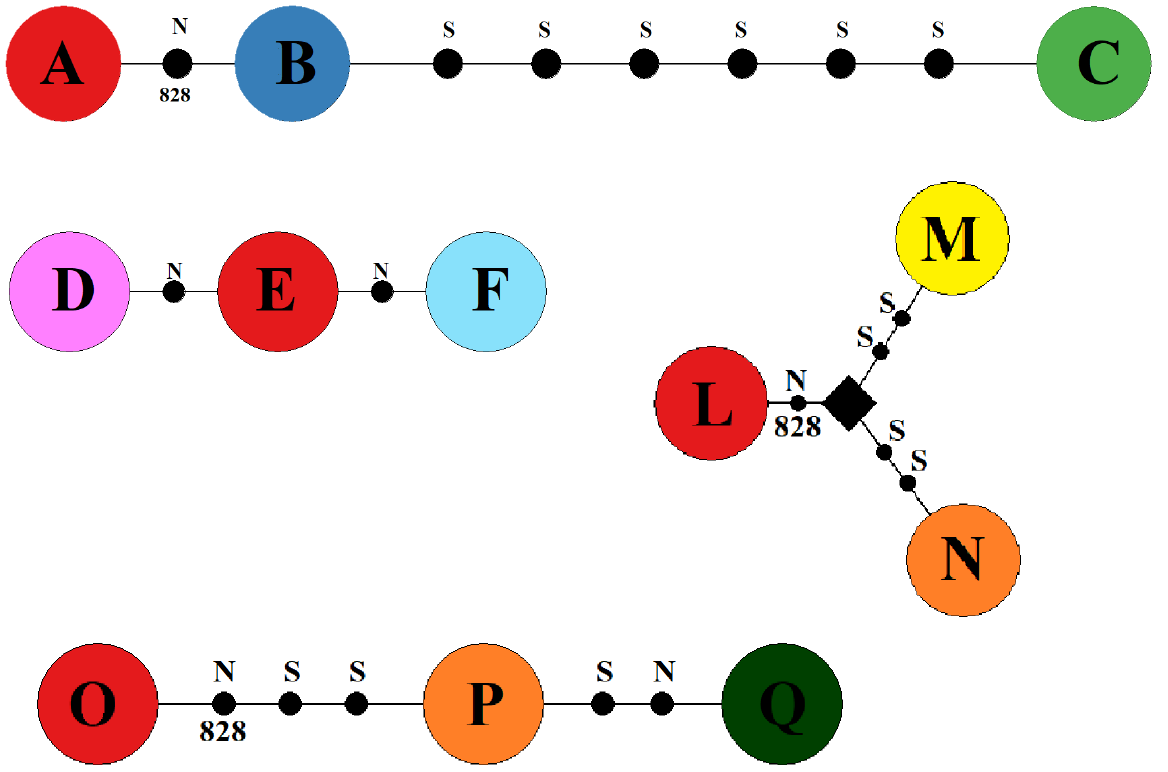
Figure 2. Haplotypes A, B and C from EB I; haplotypes D, E and F from EB II; L, M and N from EB III; haplotypes O, P and Q from EB IV; identical haplotypes are coloured with the same colour. S, synonymous mutation; N, nonsynonymous mutation; 828 A > G, a specific nonsynonymous substitution that separates the two groups of haplotypes.